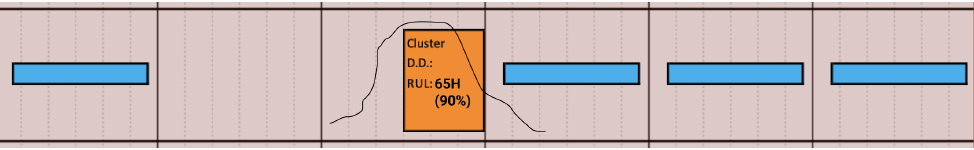
Figure 5. The participant proposed visualizing the RUL with a “probability distribution curve”, showing how it could be represented by roughly drawing the thin black curve.